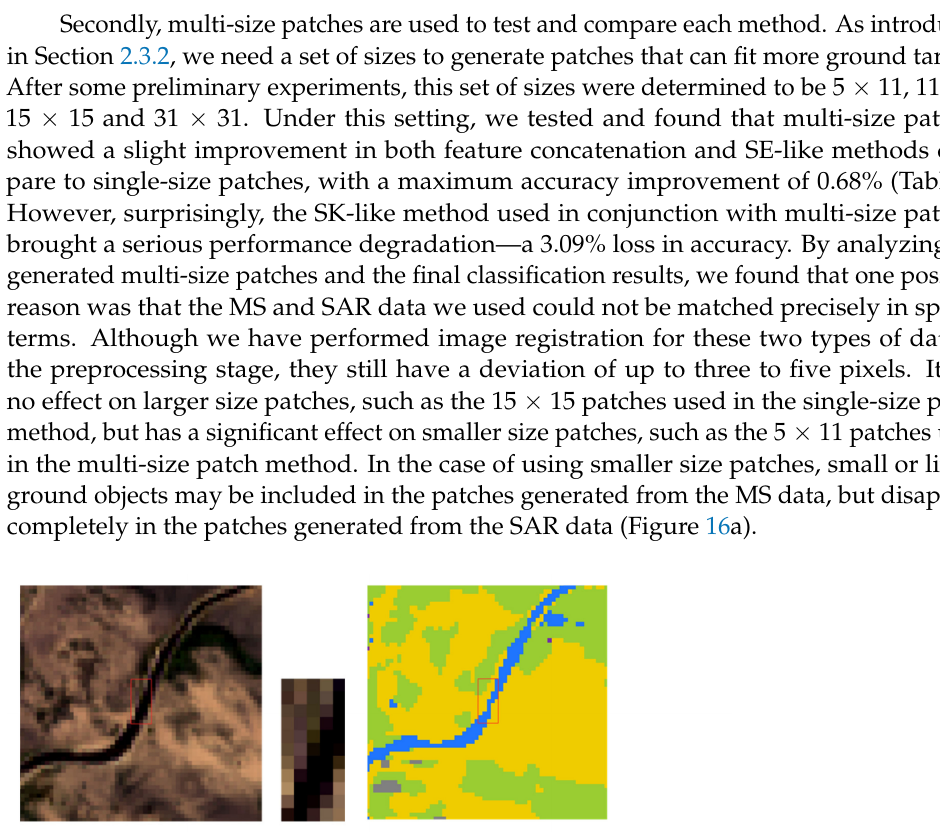
Figure 15. Different classification results using SK-like method and feature concatenation in an example area mainly contains farmland. ( a ) Source MS image; ( b ) source SAR image; ( c ) results using feature concatenation; ( d ) results using SK-like method.